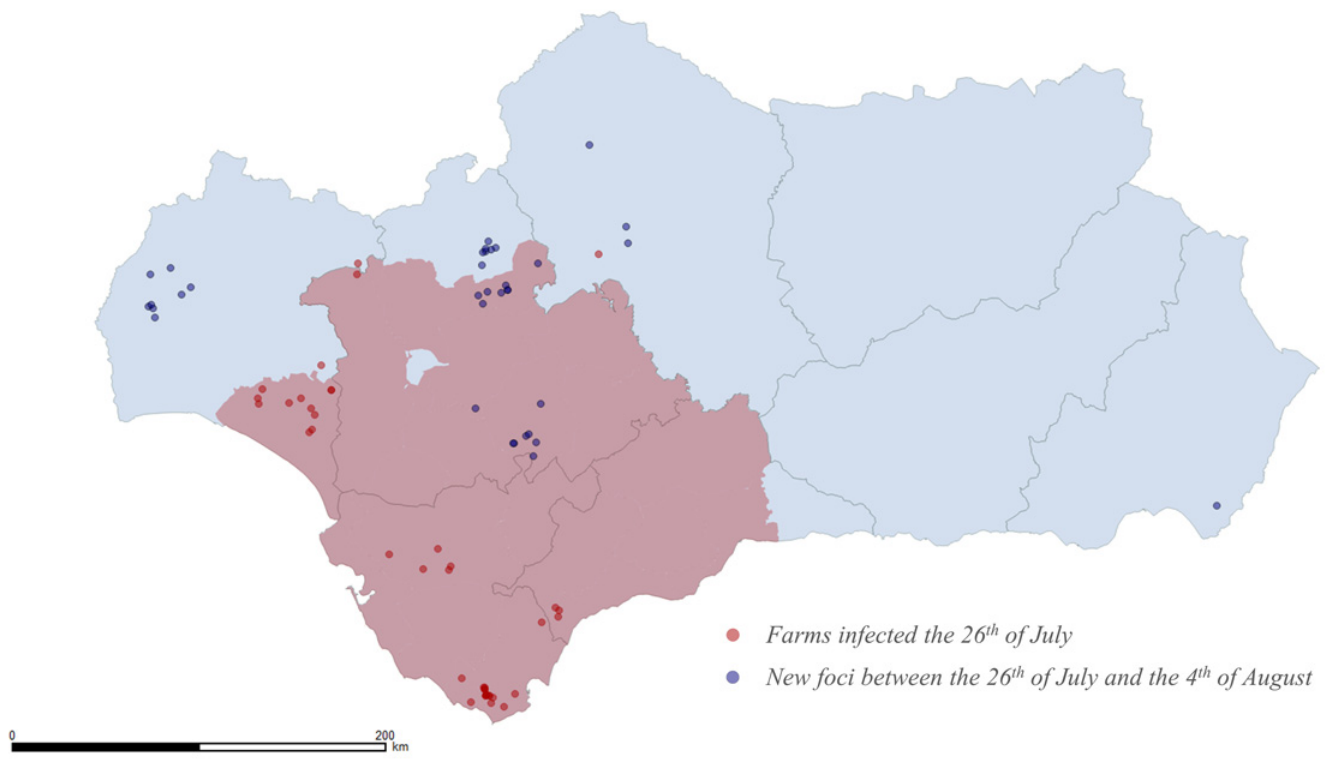
Fig 7. Movement restriction area established on the 26 th of July (red area), with the farms estimated to be infected by that date (red dots) and the new foci initiated within the 10 days that followed movement restrictions (blue dots).